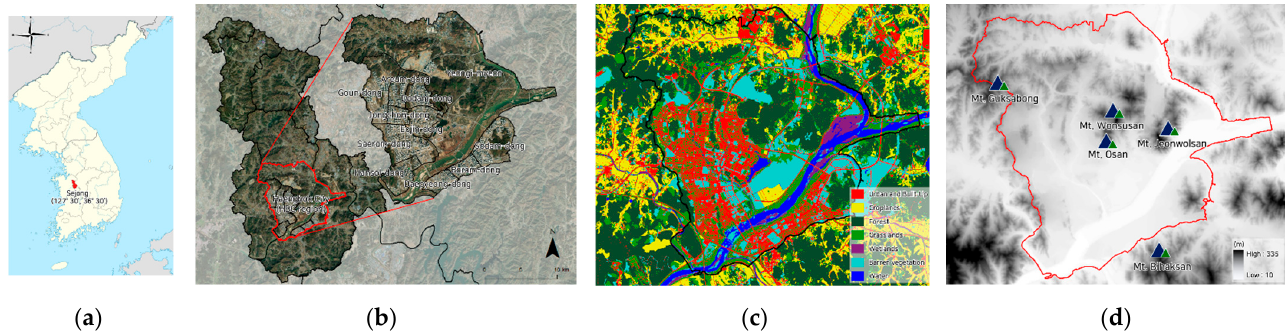
Figure 1. Maps of study area: ( a ) location of Sejong City; ( b ) study area (HBC region); ( c ) land cover of HBC region; ( d ) topography of HBC region.